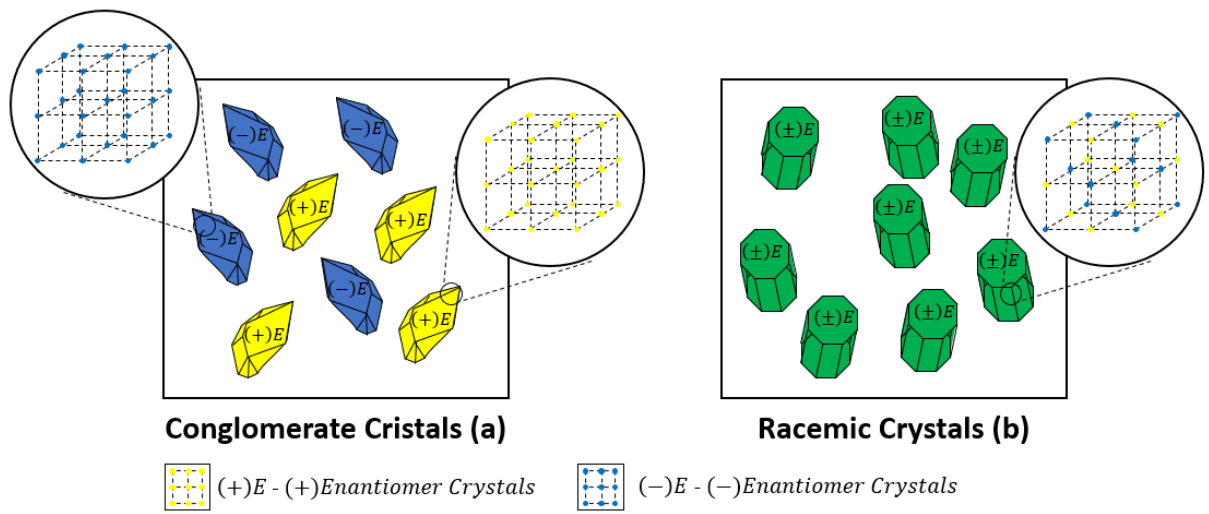
Figure 10. Illustration of conglomerate ( a ) and racemic compound ( b ) crystals. Table 5. Experimental studies of enantioresolutions applying crystallization.